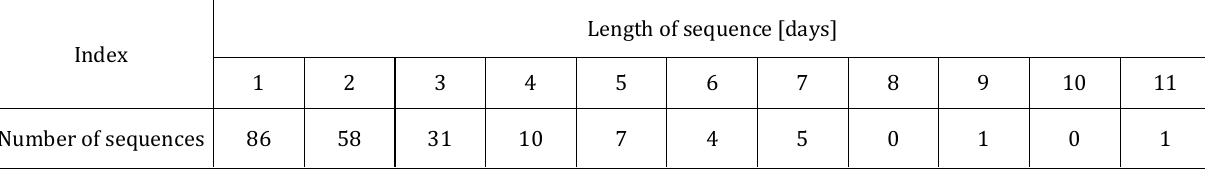
Table 6. Number and length of sequences of days with SHP recorded at all 12 grid points in the period 1951-2015